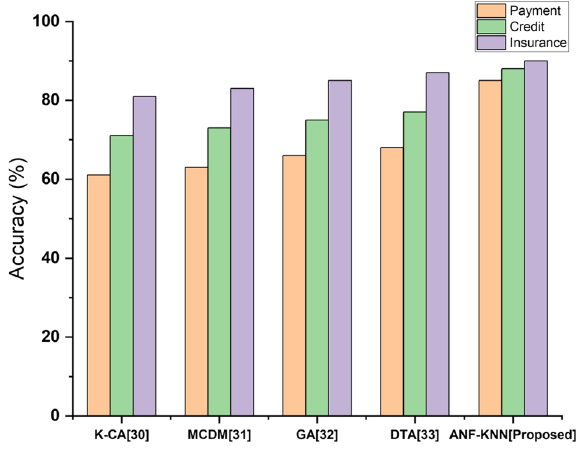
Fig. 9 Accuracy comparison of existing and proposed